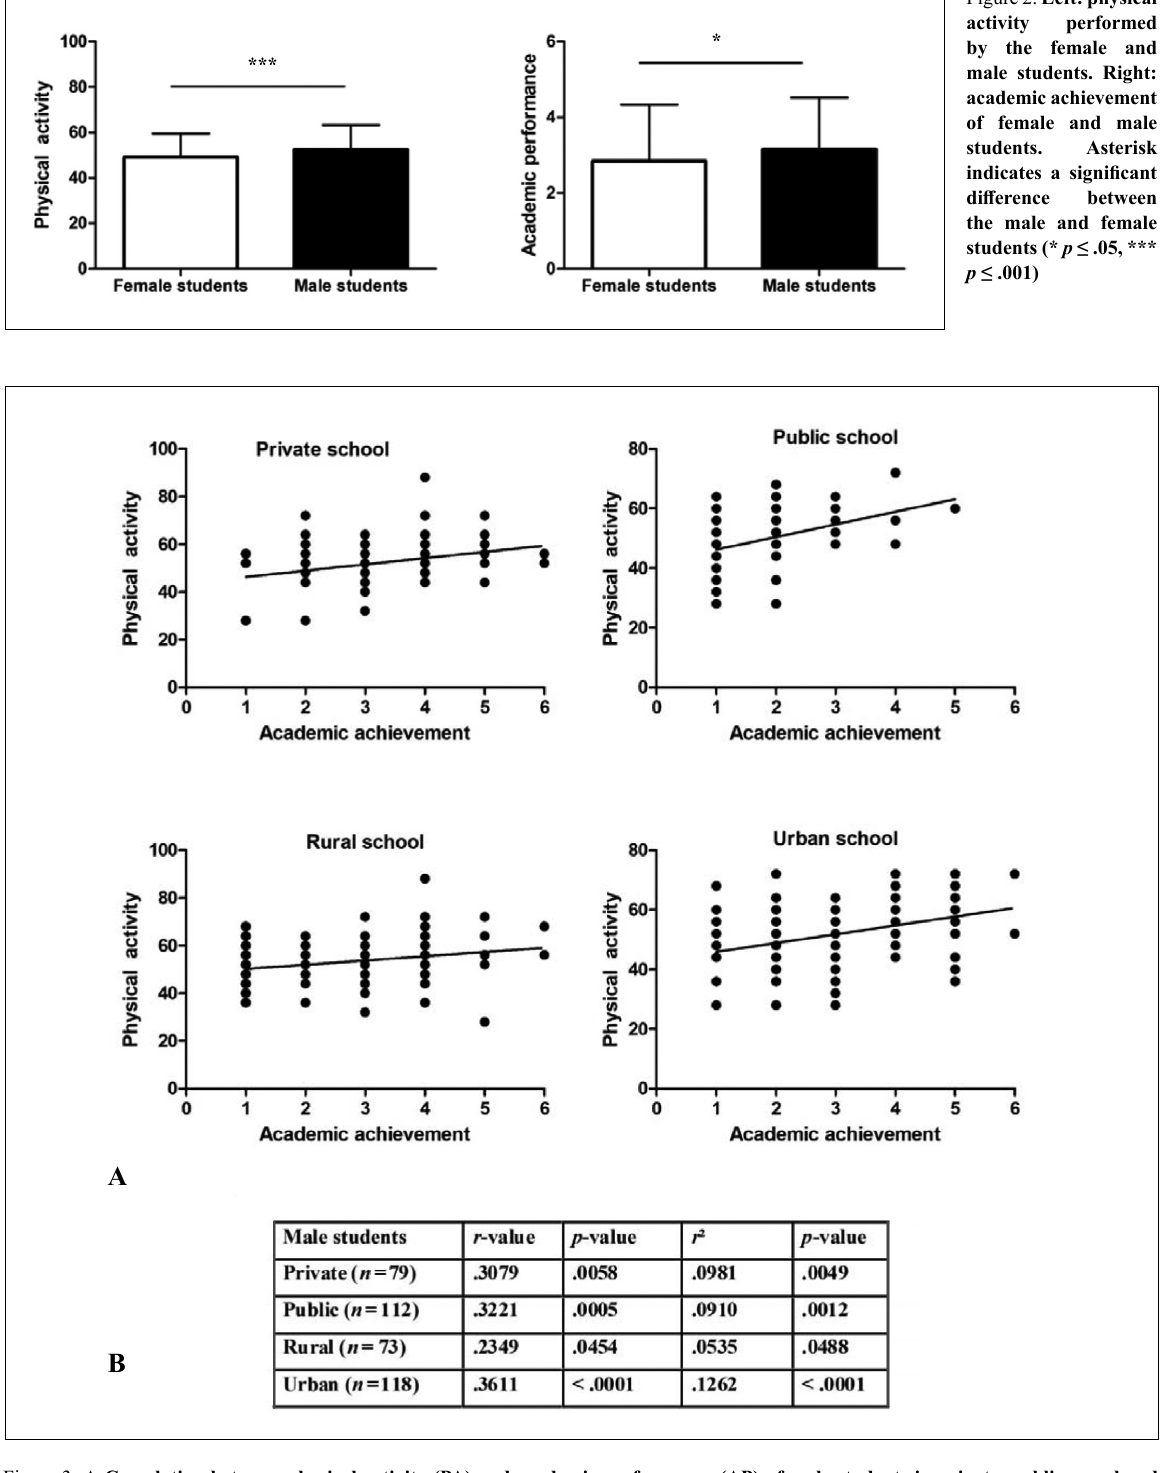
Figure 3. A-Correlation between physical activity (PA) and academic performance (AP) of male students in private, public, rural and urban Schools. B-corresponding table illustrating spearman correlation coefficient ( r ) and goodness of fit ( r 2 ) Note. n – number of